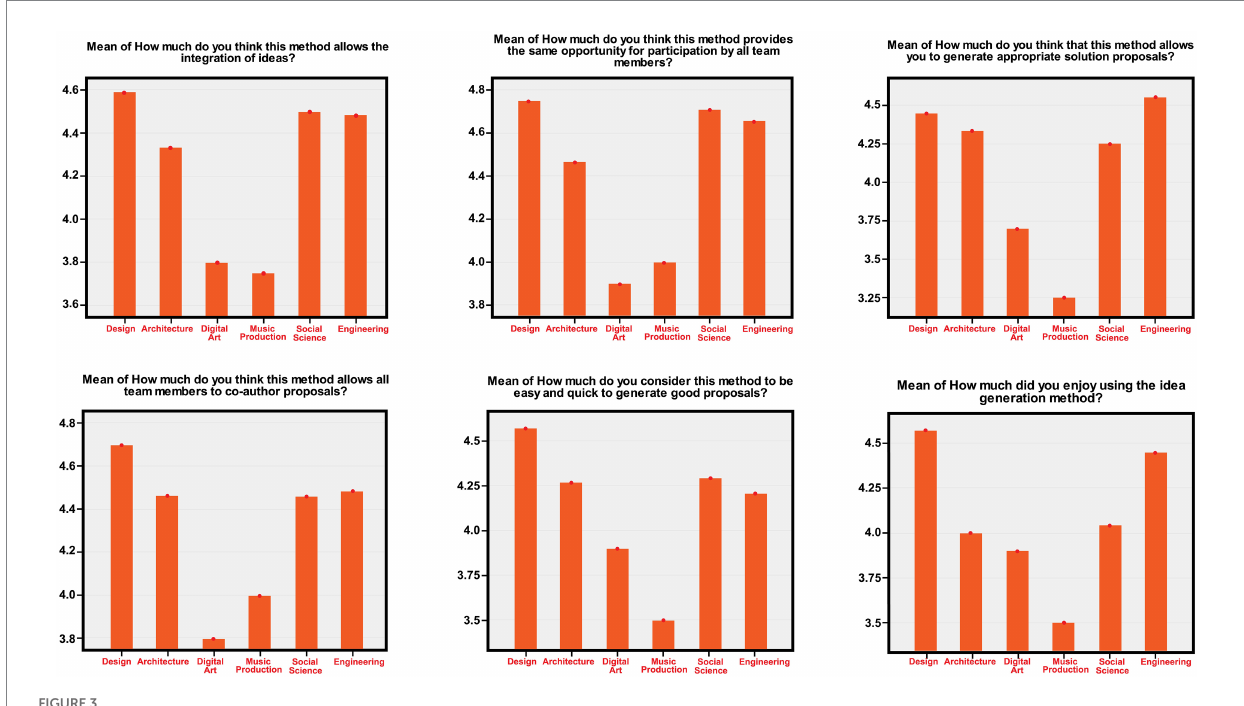
FIGURE 3 Plots of means for careers and perception-experience